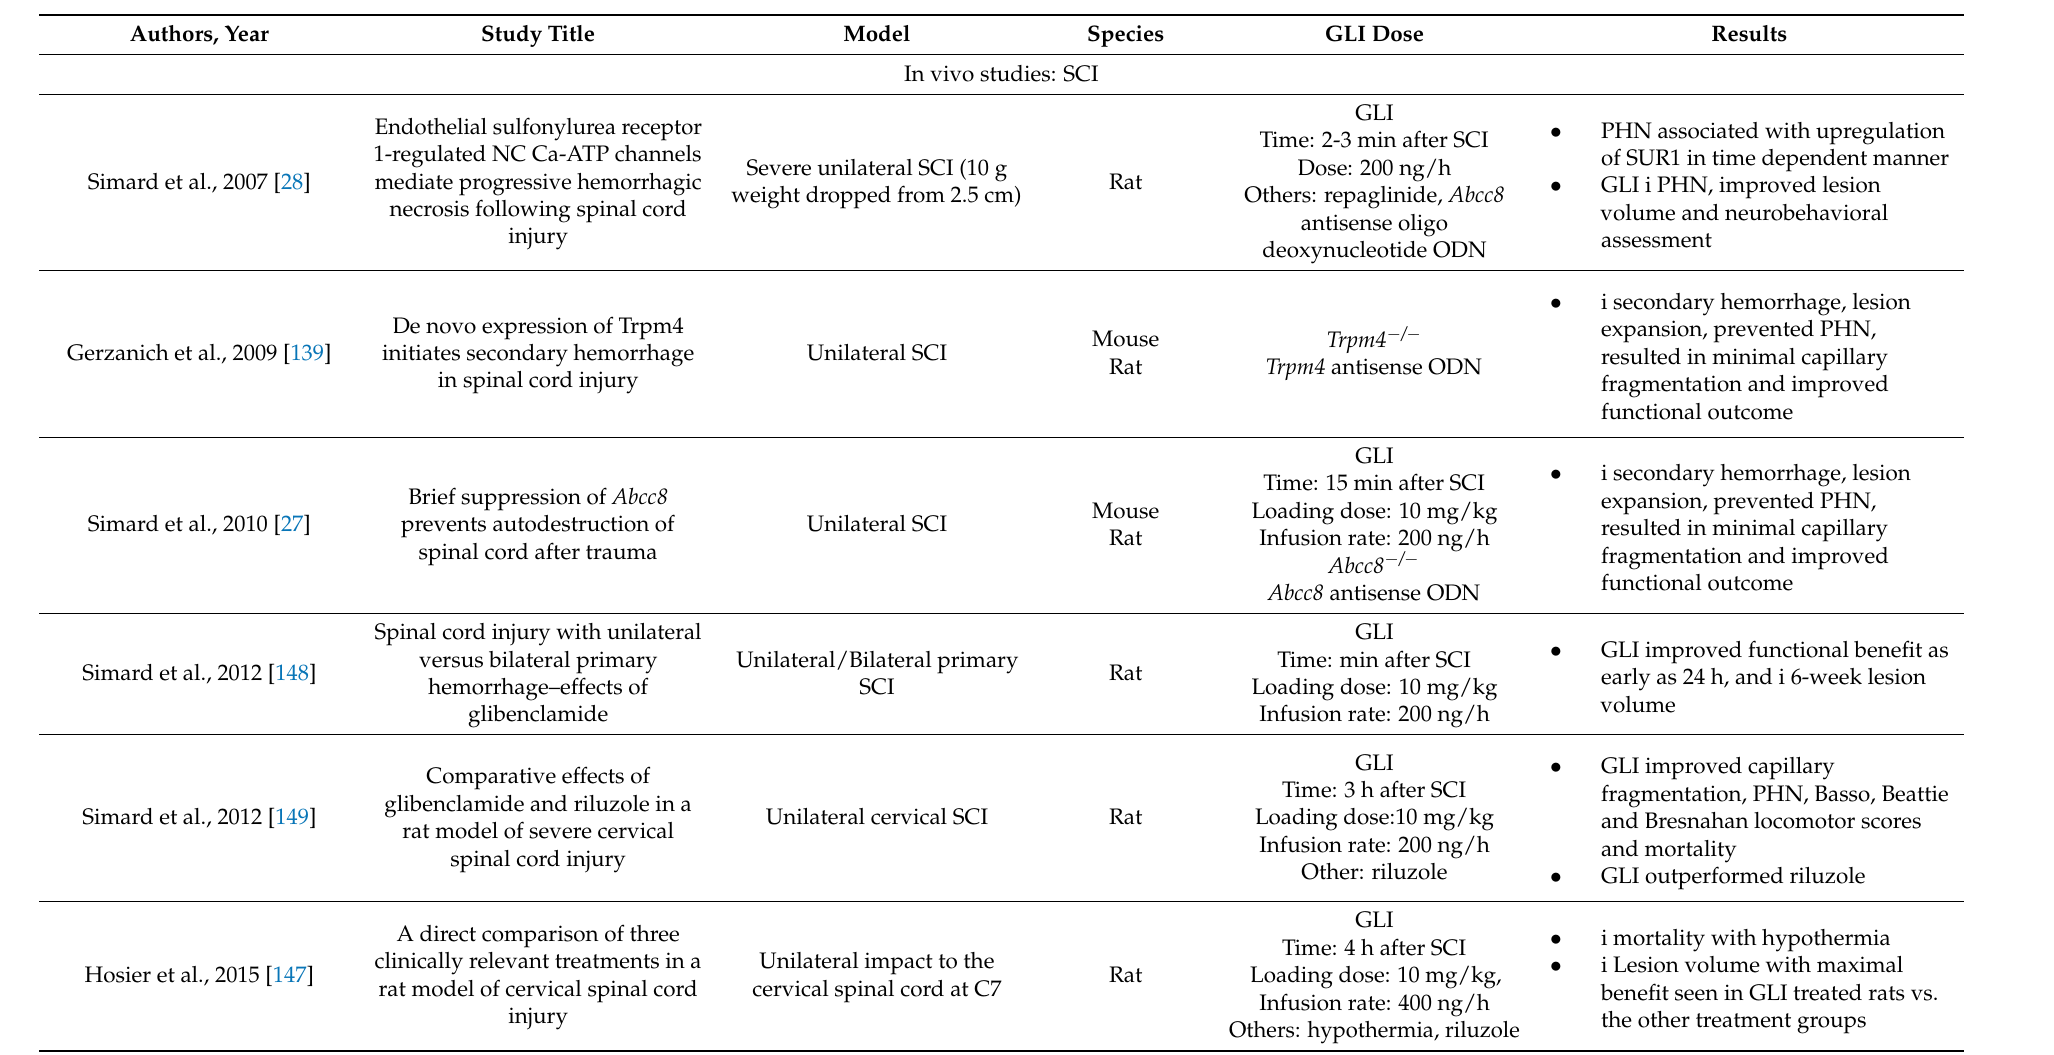
Table 5. Pre-clinical and clinical studies evaluating SUR1 inhibition for spinal cord injury